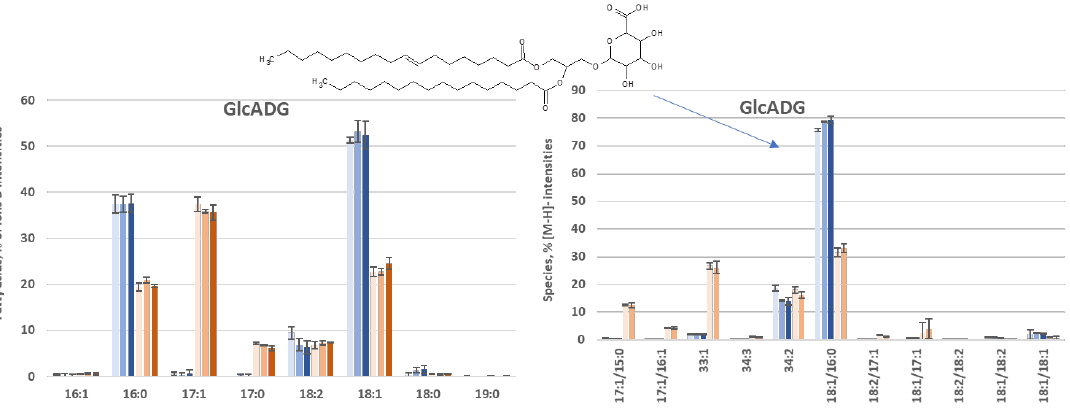
Figure 8. Comparison of %FA profiles in the GlcADG during OCFA production in the obese L (Blue) and obese LP (orange) over time (72, 144 and 216